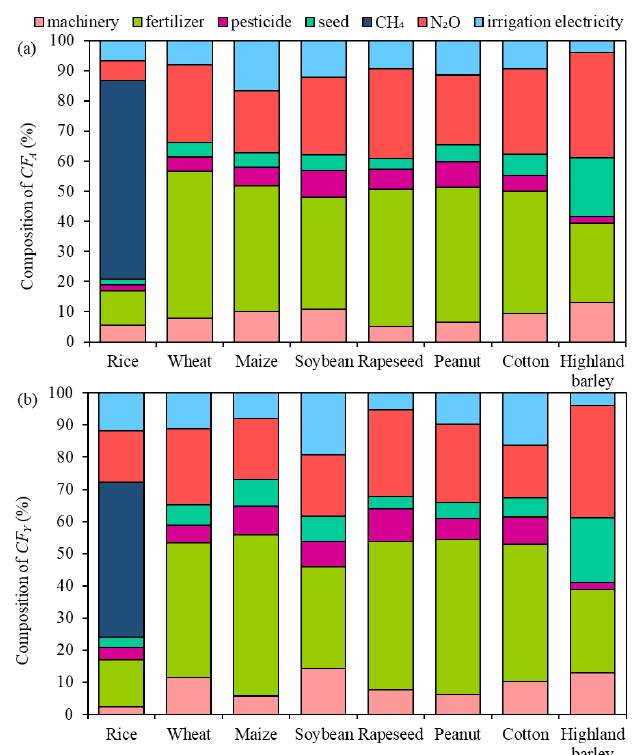
Figure 6. Compositions of the annual mean carbon footprints ( a ) per unit area and ( b ) per unit yield for different crops in China from 1990 to 2019.